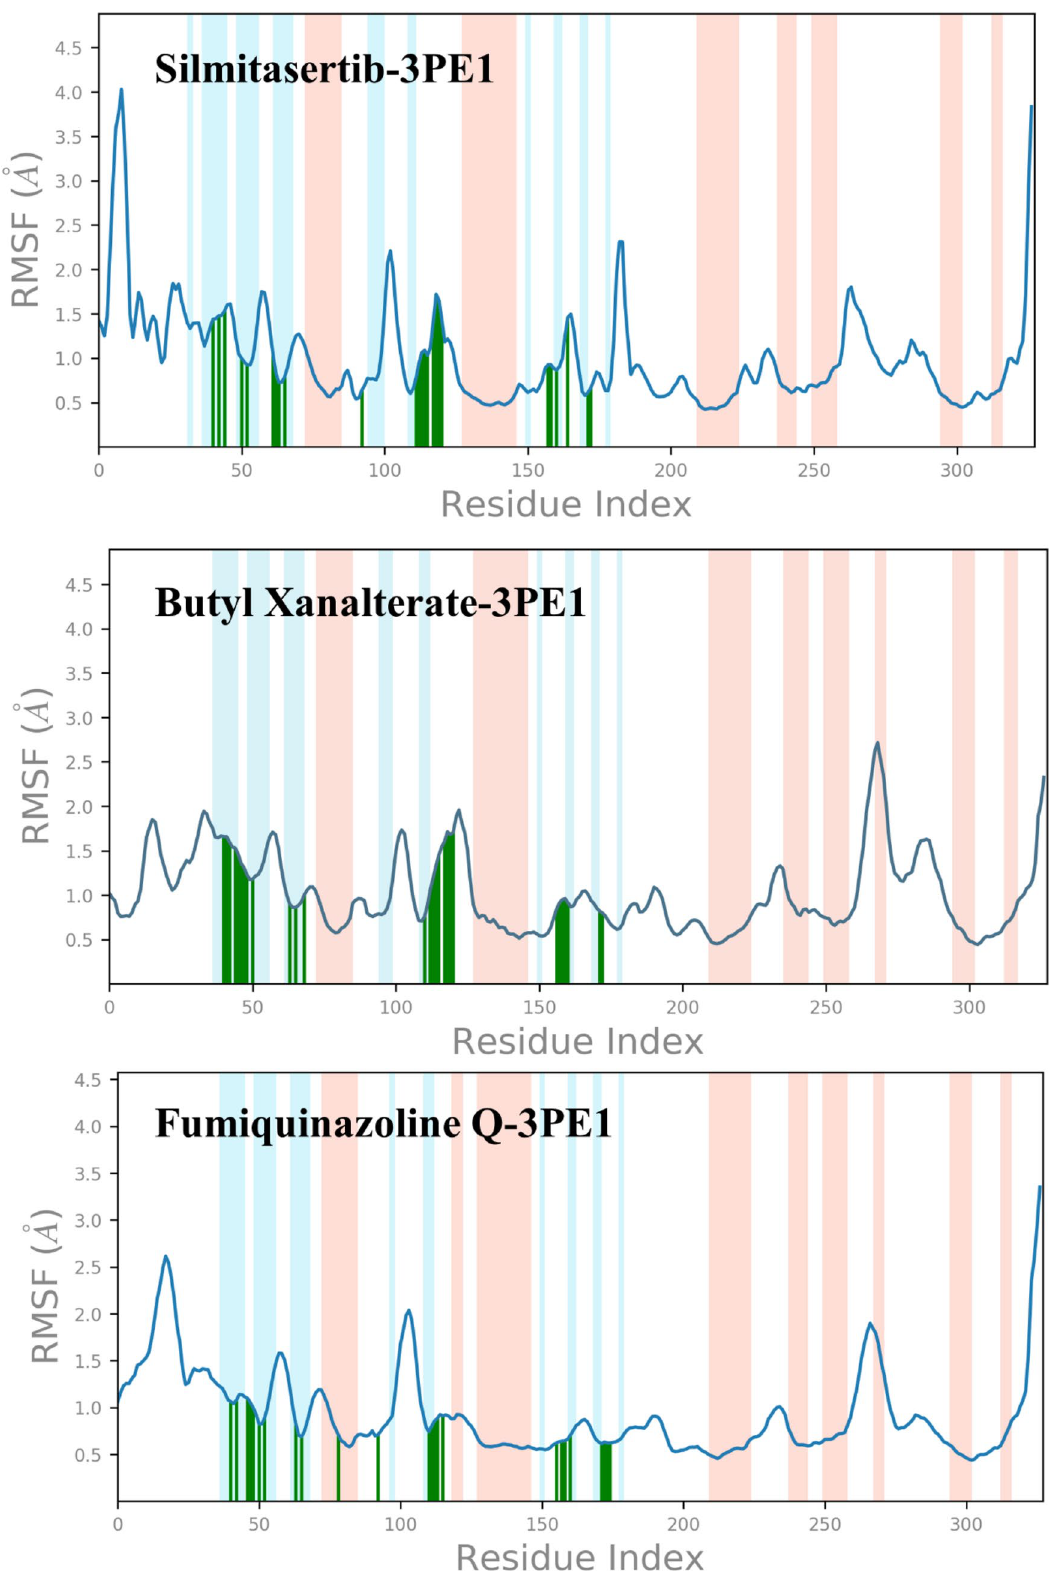
Figure 8. RMSF of human protein kinase CK2α subunit upon ligand binding, amino acid that interacted with ligand marked in green vertical